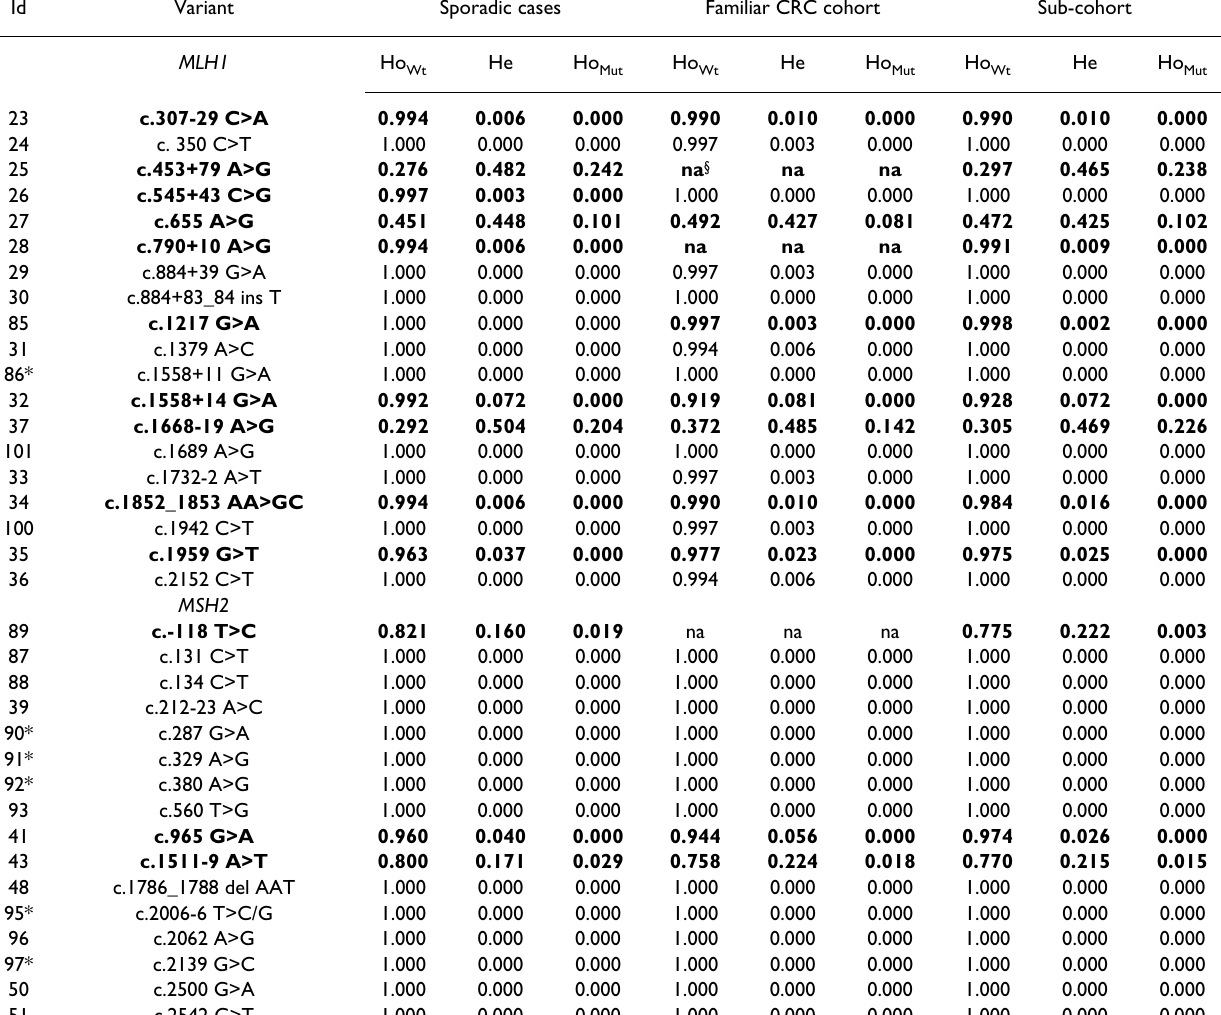
Table 3: Genotype frequencies of the variants in the analyzed cohorts Id Variant Sporadic cases Familiar CRC